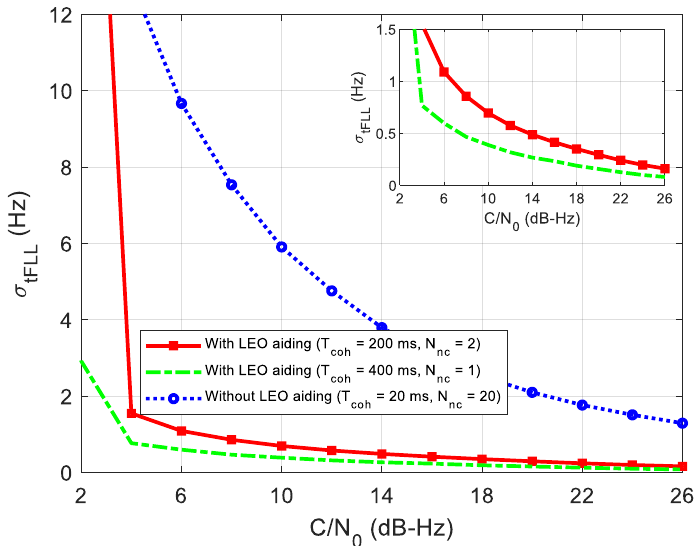
Figure 13. FLL frequency jitter caused by thermal noise.